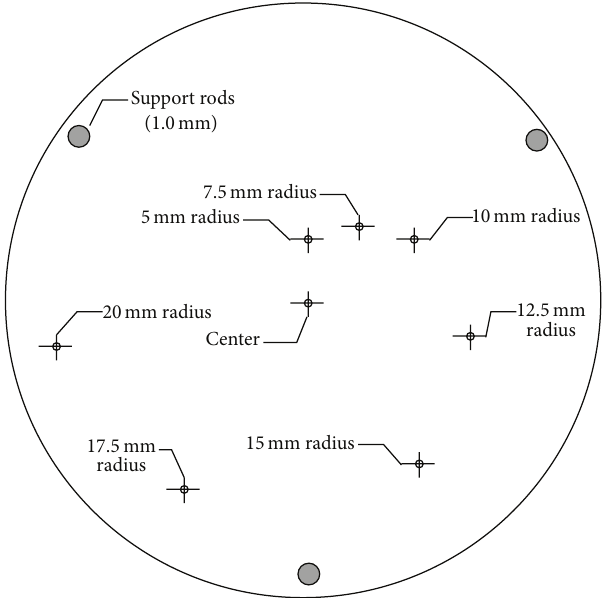
Figure 4: Transmission spatial resolution phantom dimensions.